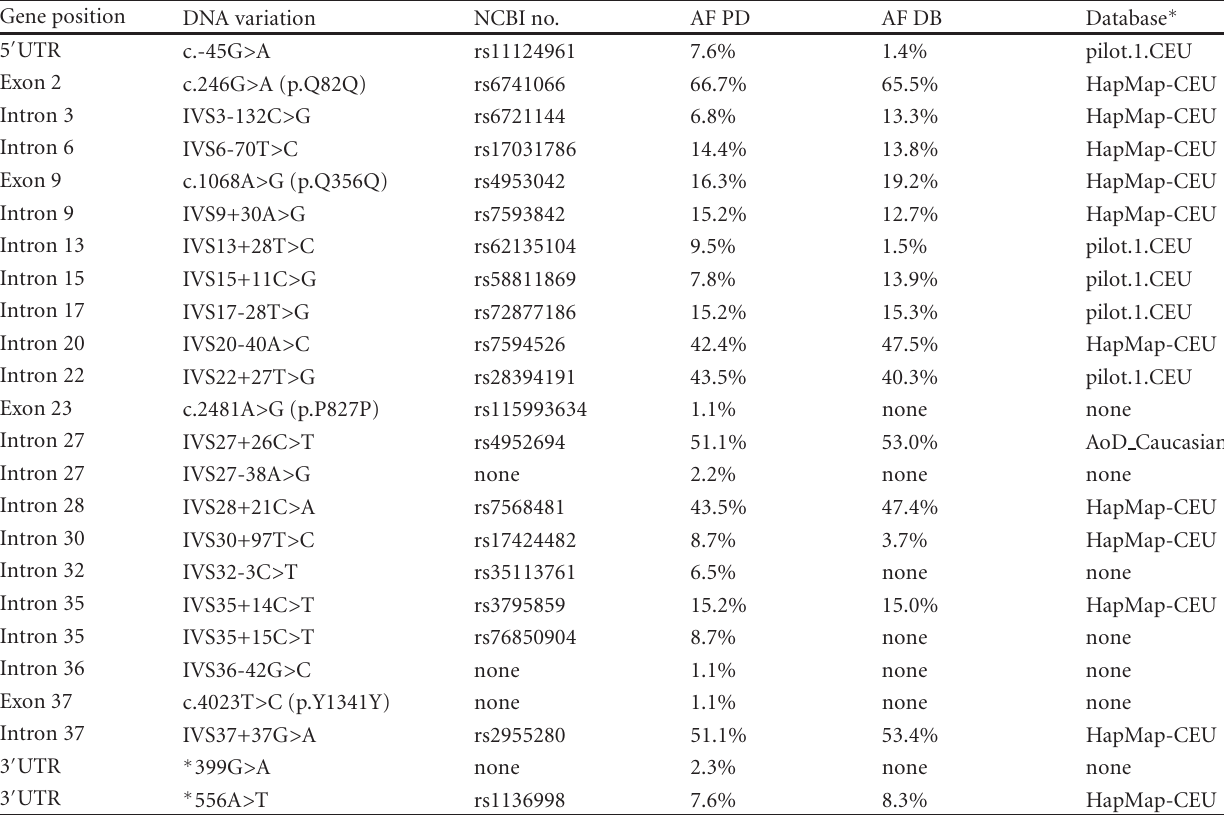
Table 2: Allelic frequencies of sequence variations identified in LRPPRC